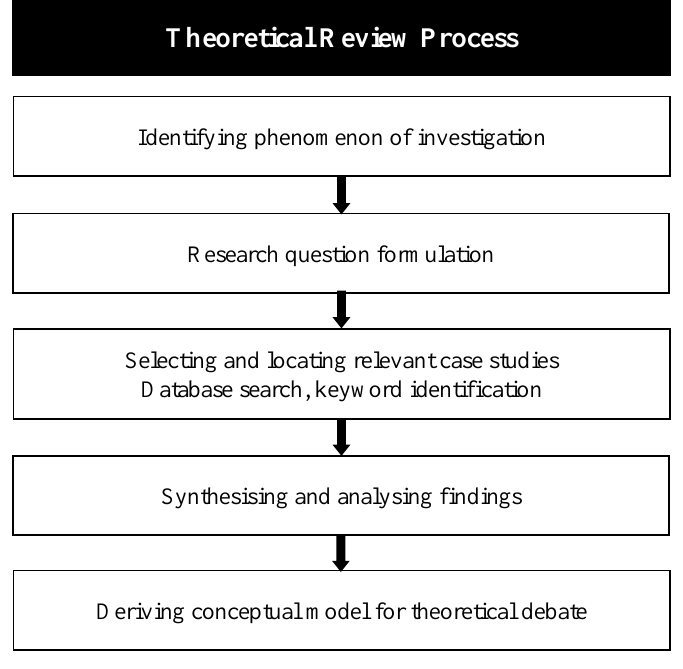
Figure 6. Methodology of the theoretical